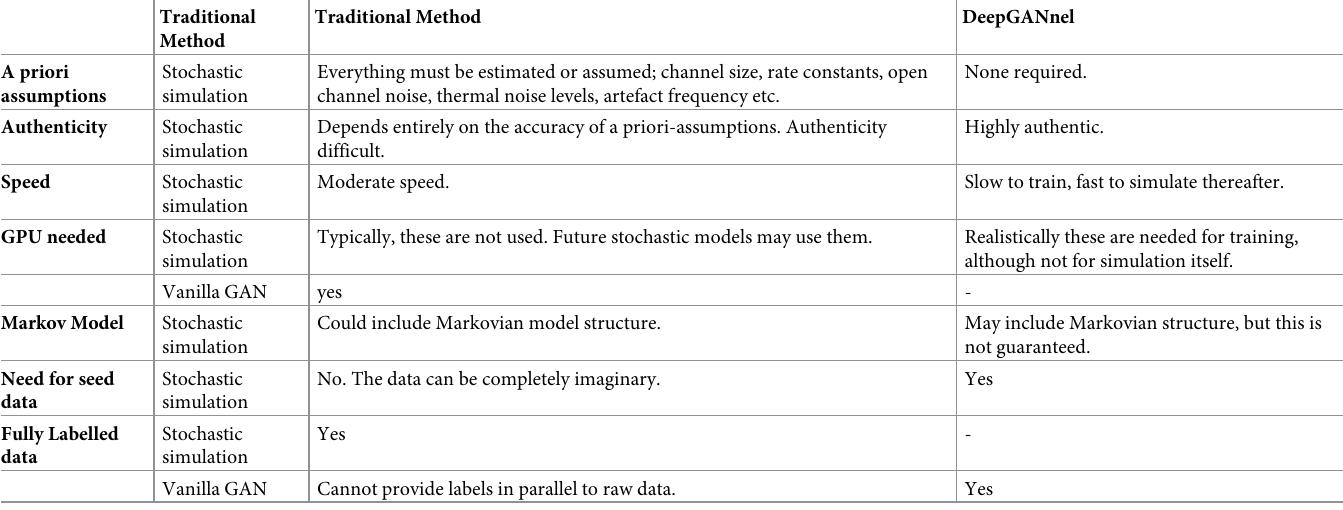
Table 5. Likely strengths and weaknesses of DeepGANnel versus traditional synthesis